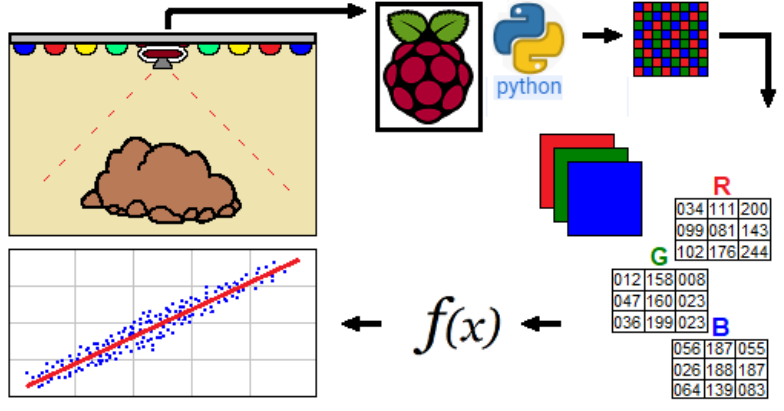
Figure 1. Representation diagram of the